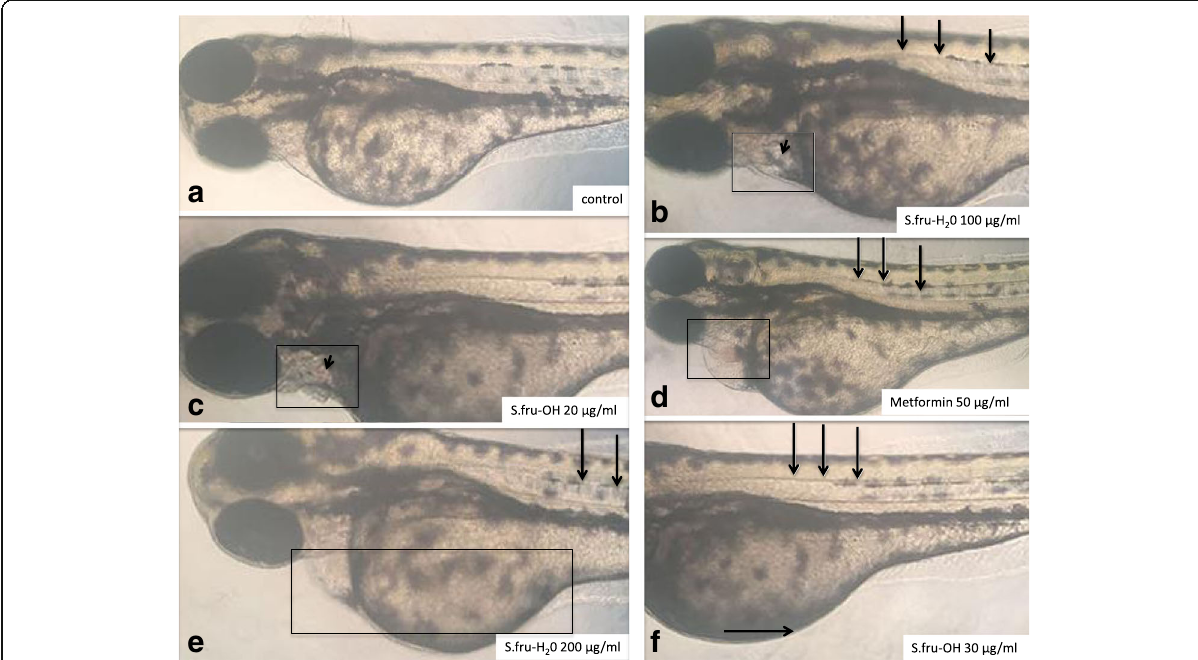
Fig. 1 Embryos treated with different concentrations of S.fru-OH or S.fru-H 2 O at 96 hpf. a An example of a control (untreated) embryo with a normally developed straight spine without any visible signs of bleeding. b The short arrow points to a darkened region where a cyst is forming. The boxed zone highlights the pericardial region. c The short arrow points to a pink discolouration within the pericardial zone (shown using a rectangle). d A distinct pink sphere is visible within the pericardial zone (rectangle) and long arrows point to a curving spine. e A clear mass of tissue and an enlarged abdominal region is highlighted by the rectangle. f Long arrows point to a slightly curving spine. Pericardial cyst formation caused by exposure of zebrafish embryos to S.fru-H 2 O at 100 and 200 μ g/ml was also accompanied by enlarged bellies (shown here by a horizontal